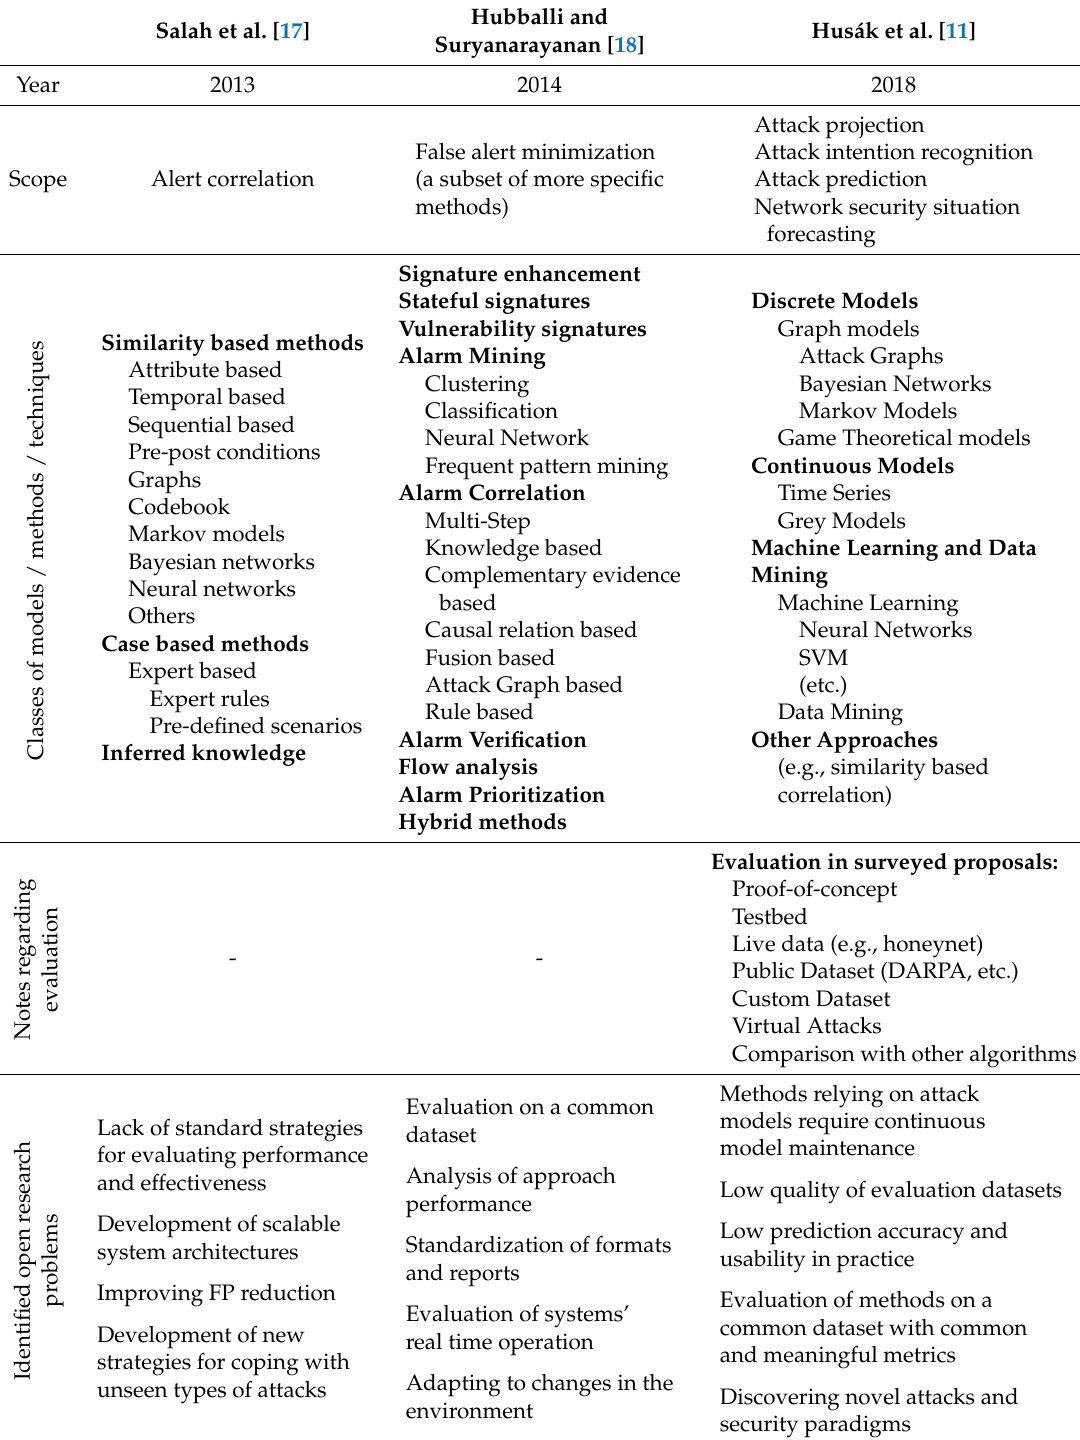
Table 1. Overview of analyzed surveys in attack detection and